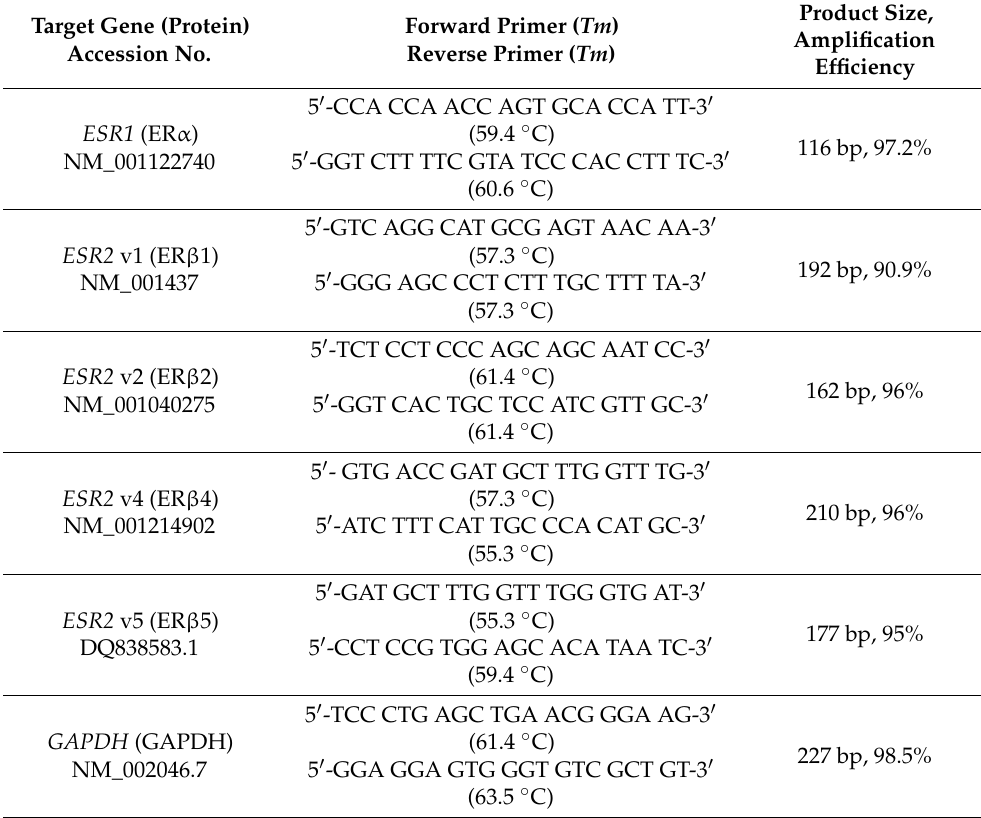
Table 1. Primers used for quantitative real-time